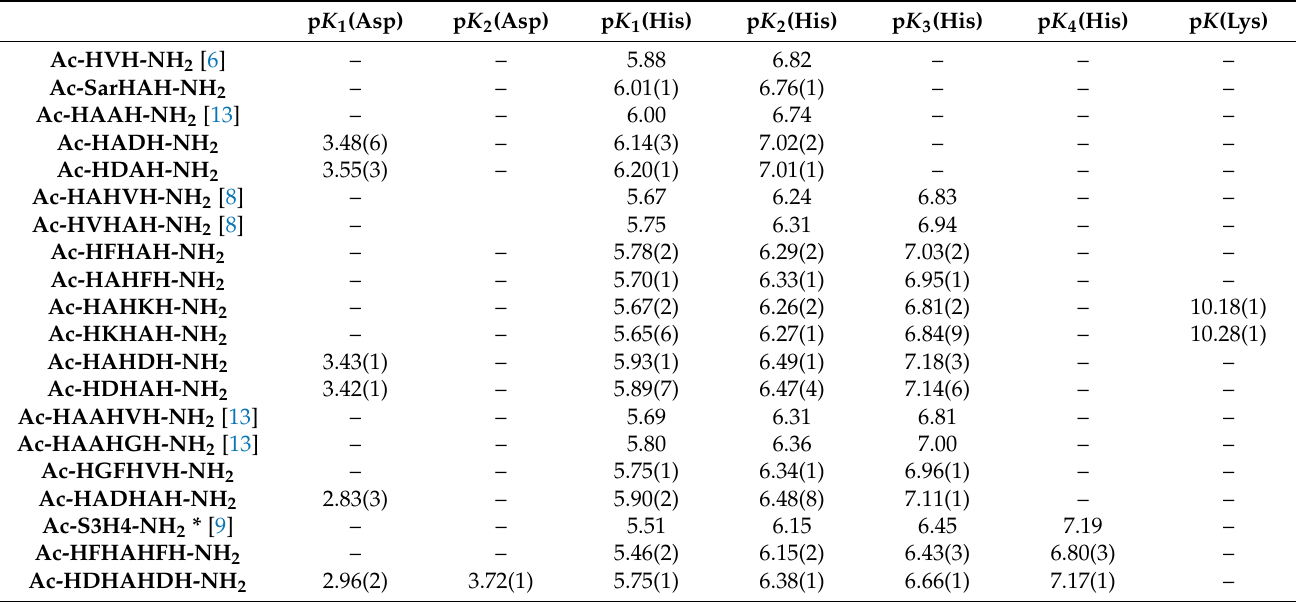
Table A1. The deprotonation constants of peptides completed with literature